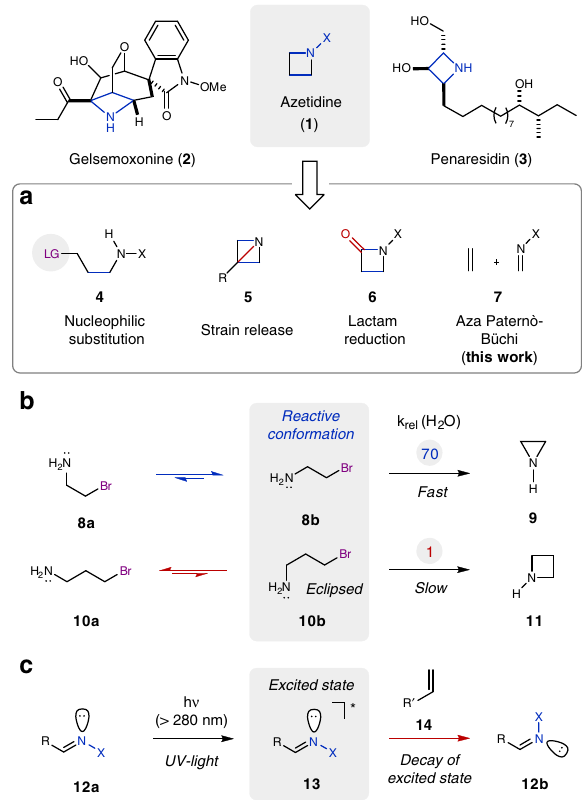
Fig. 1 Previous strategies towards azetidines and this approach. a Select synthetic strategies. b Challenges in nucleophilic substitution